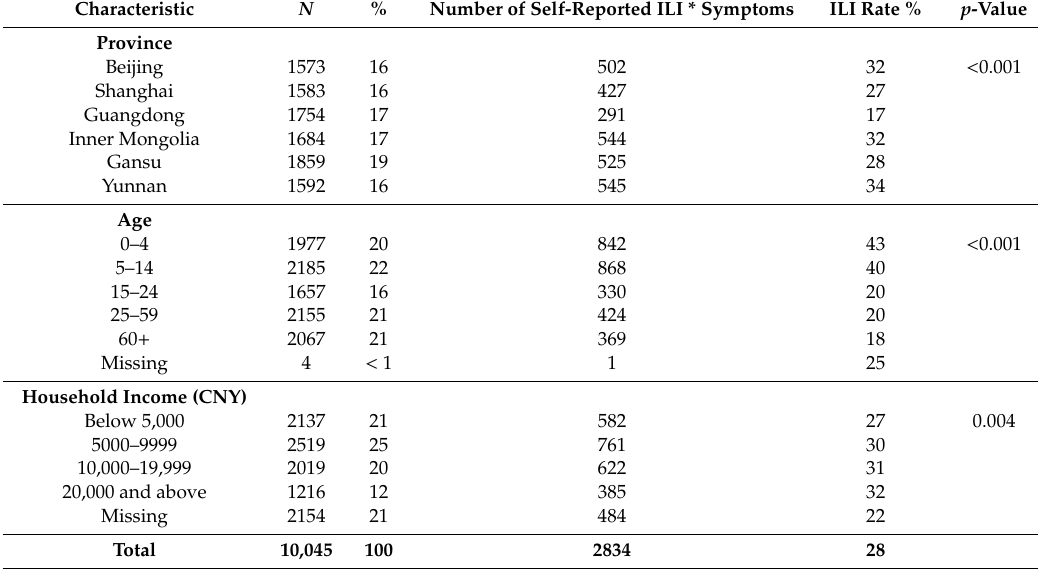
Table 1. Demographic characteristics of individuals targeted in a telephone survey in six provinces